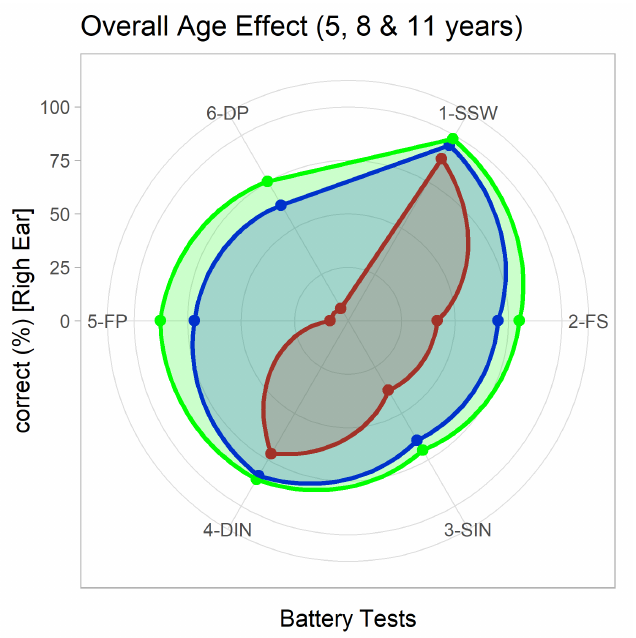
Figure 3. Simultaneous representation of the average percentage of correct answers for the 6 tests of the battery using a Radar plot. Values for 3 ages are presented: 5 years (in red), 8 years (blue) and 11 years